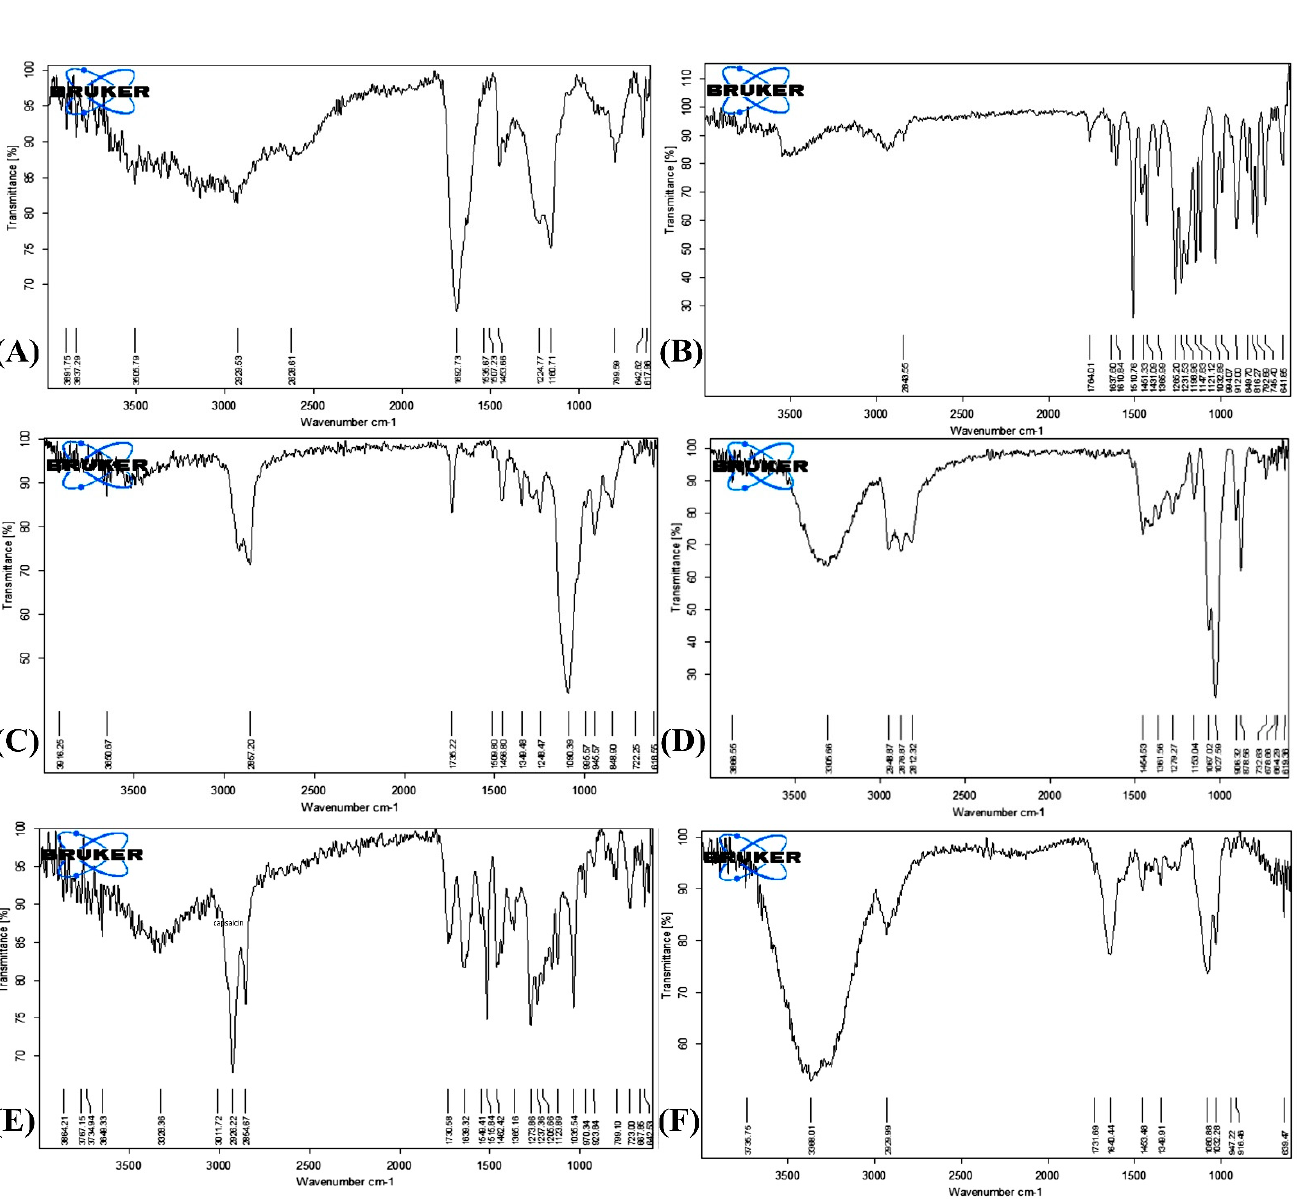
Figure 3. FTIR spectrum of: ( A ) Carbopol 934; ( B ) clove oil; ( C ) Tween 80; ( D ) triethanolamine; ( E ) capsaicin; ( F ) optimized transemulgel formulation. Table 3 . Various peaks obtained from FTIR spectra of capsaicin, clove oil, Tween 80, triethanola- mine, Carbopol 934, and optimized formulation.